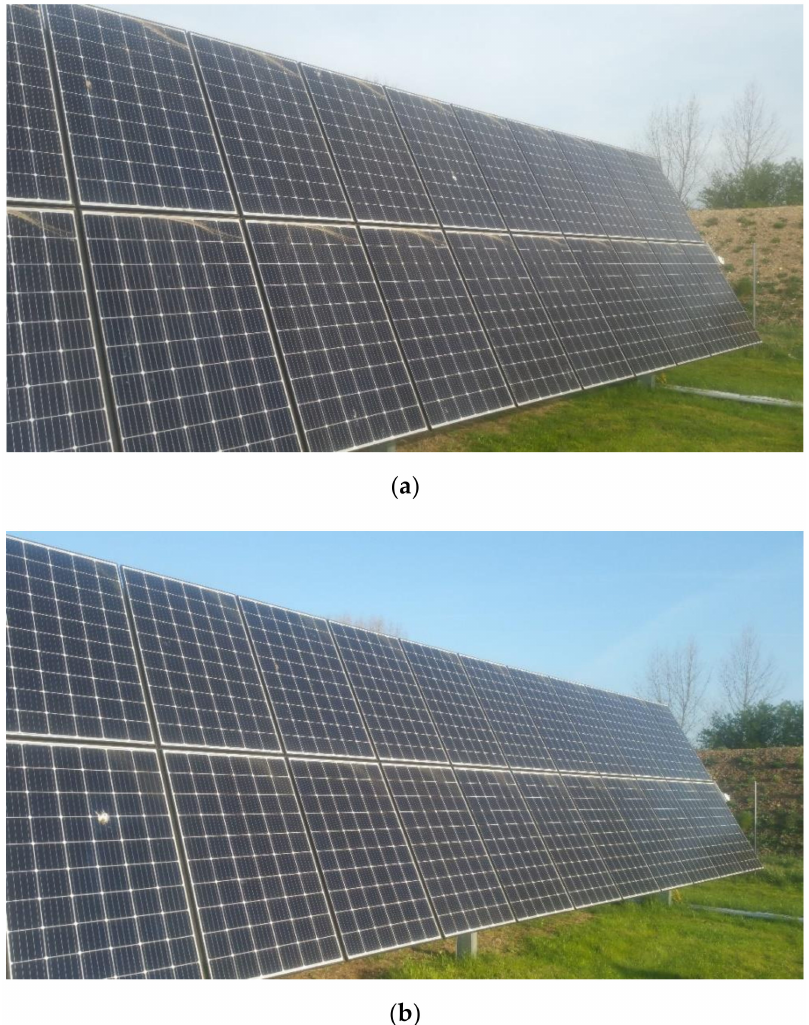
Figure A2. Monofacial HSAT array before and after a rainfall event in late April. The unusually high bifacial gains in April are attributed to the soiling present before the rainfall event. ( a ) Soiling from pollen (26 April 2019). ( b ) Reduced soiling after rainfall event (29 April